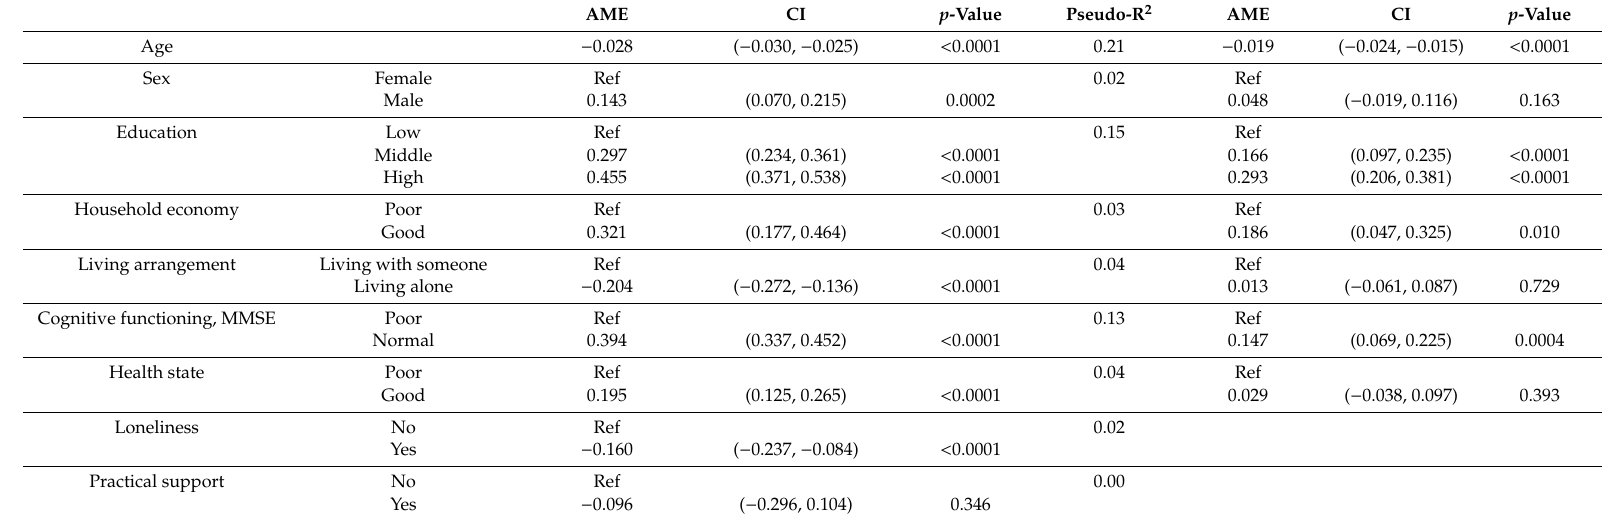
Table 5. Univariate and multivariate binary logistic regression analyses. Internet use as a dependent variable. Average marginal e ff ects (AME) with 95% confidence intervals (CI) for the factors and p -values for the beta-coe ffi cients.